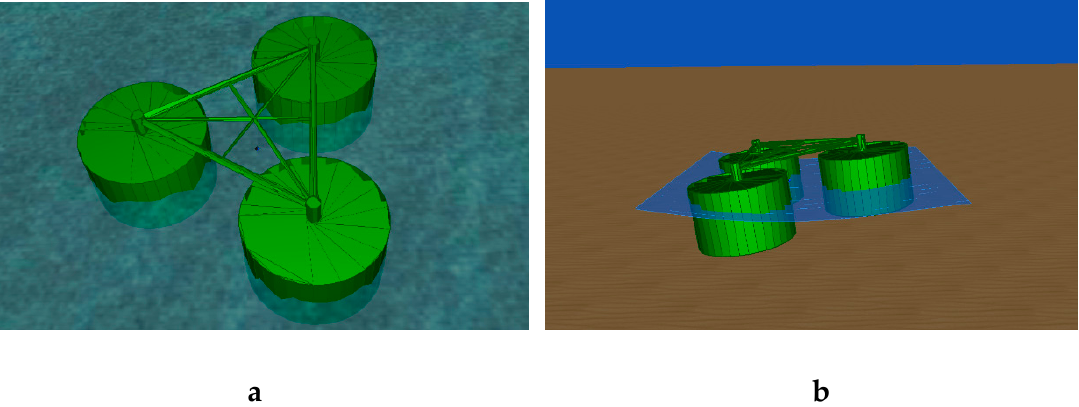
Figure 10. Hydrodynamic models by MOSES: ( a ) foundation in still water; ( b ) foundation in wave.